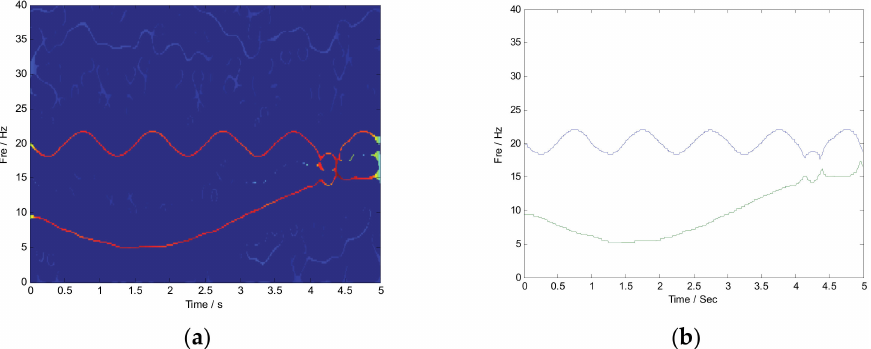
Figure 6. The result calculated by the proposed improved synchroextracting chirplet transform (ISECT) method. ( a ) Result provided by the proposed method; ( b ) Extracted ridge form the optimized TF